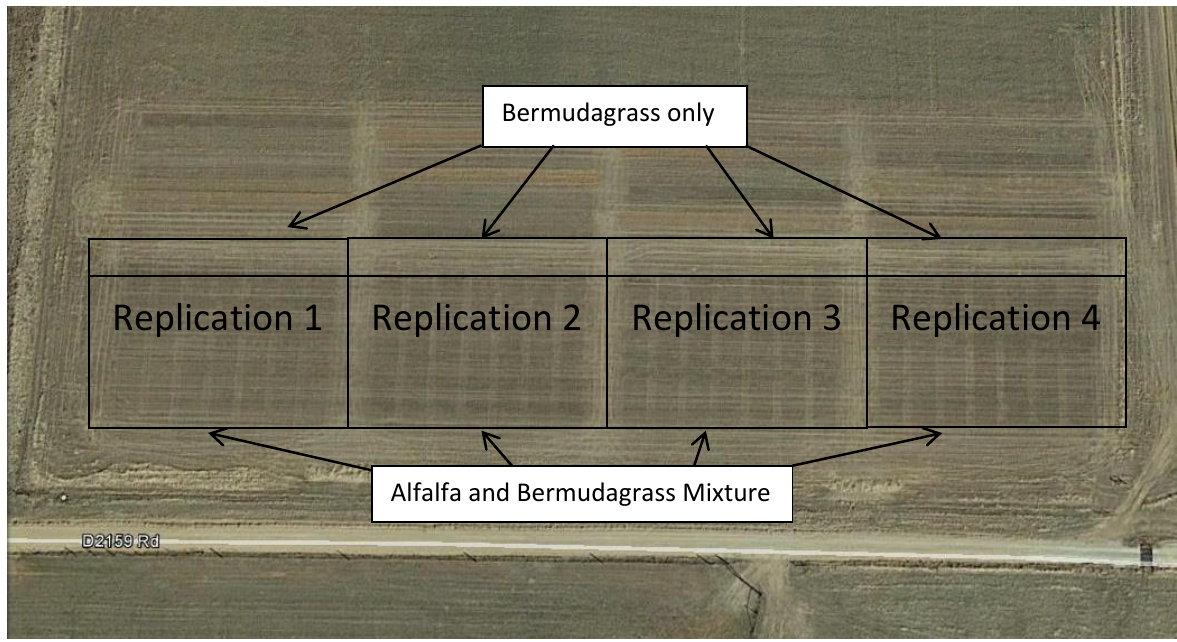
Figure 1. Aerial imagery of alfalfa and bermudagrass Trial. courtesy google